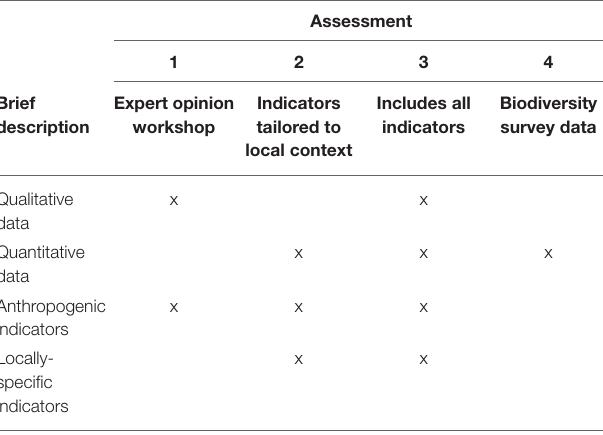
TABLE 2 | Overview of different resilience assessments and comparison of approach